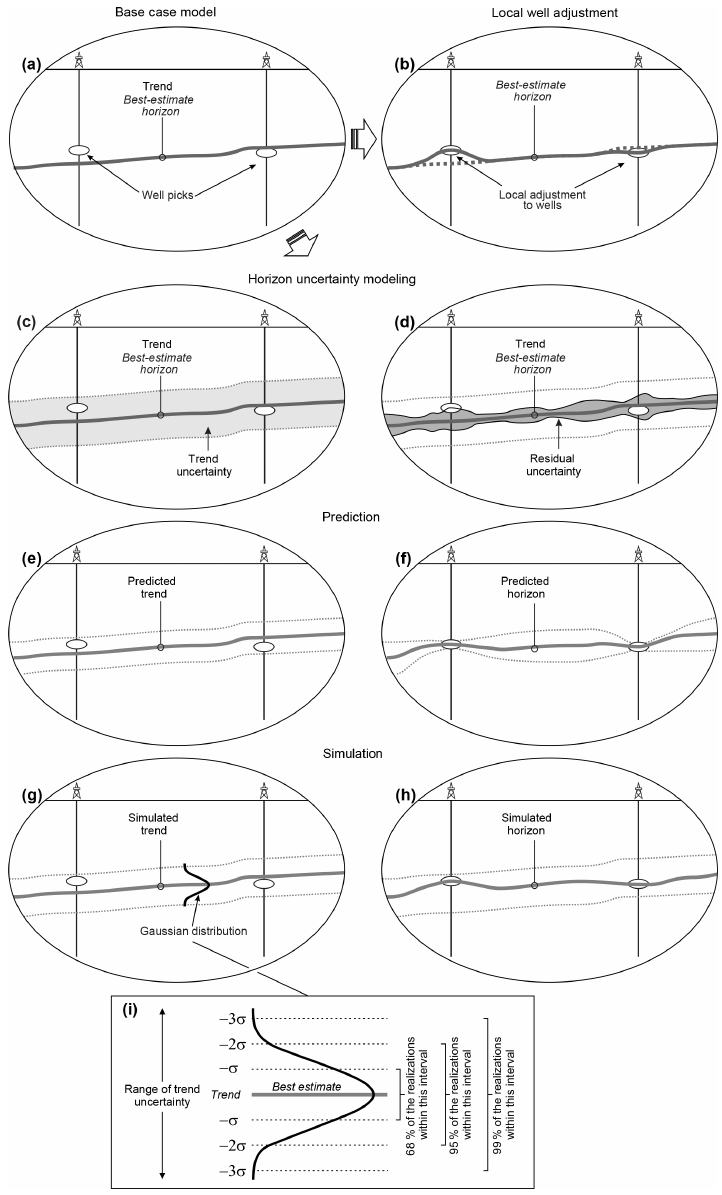
Figure 7. Diagram showing the steps of the horizons’ uncertainty modeling. (a) Initial situation with the best-estimate interpretation of a horizon, which corresponds to the trend. This interpretation does not fit the well picks (i.e., wells observations, markers, well tops). (b) If the horizon uncertainty is not considered, typically the horizon interpretation is locally adjusted to the well picks. If the uncertainty is modeled, then the trend uncertainty range (c) and the residual uncertainty (d) are estimated. In the prediction method, the most like position of the trend is found (e) and the residual uncertainty is added to locally adjust the trend to the well picks (f) . In simulation, a trend is simulated considering the trend uncertainty range and assuming a Gaussian distribution (g) . Subsequently, the residual is included to add local variability and to adjust the horizon to the well observations (h) . Since a Gaussian distribution is considered for modeling the trend, the estimation of the trend uncertainty range must consider the percentage of the realizations to be modeled within the selected range (i)